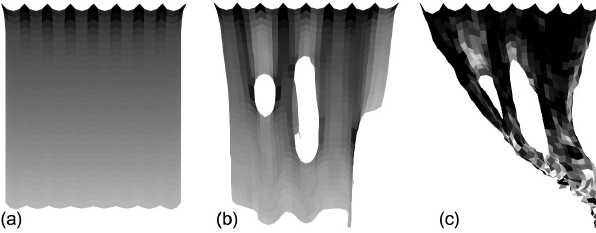
FIG. 3. A piece of cloth is simulated using particles that interact with the nearest neighbor with a force based on Hooke ’ s law. The color shading represents how much a spring is elongated with light color representing small elongation and dark color repre- senting long elongation. (a) A piece of cloth is hanging, only influenced by gravity. (b) The piece of cloth is cut using the left mouse button, the cloth reacts in real time. (c) The torn cloth is pushed around by the mouse using the right mouse